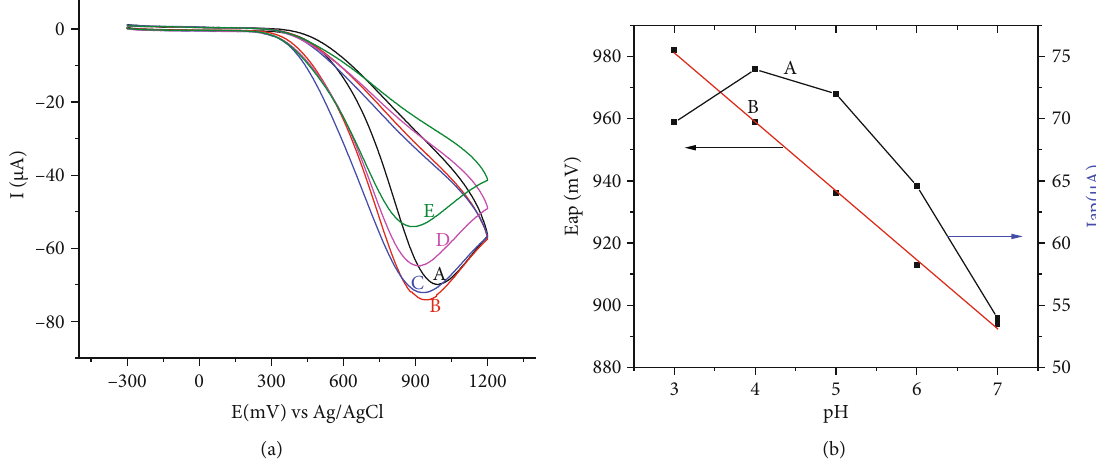
Figure 2: (a) Cyclic voltammograms of AQMCPE in PBS of various pHs (A – E: 3.0, 4.0, 5.0, 6.0, and 7.0, respectively) containing 2.0mM AA. (b) Plot of (A) anodic peak current and (B) anodic peak potential vs. pH.